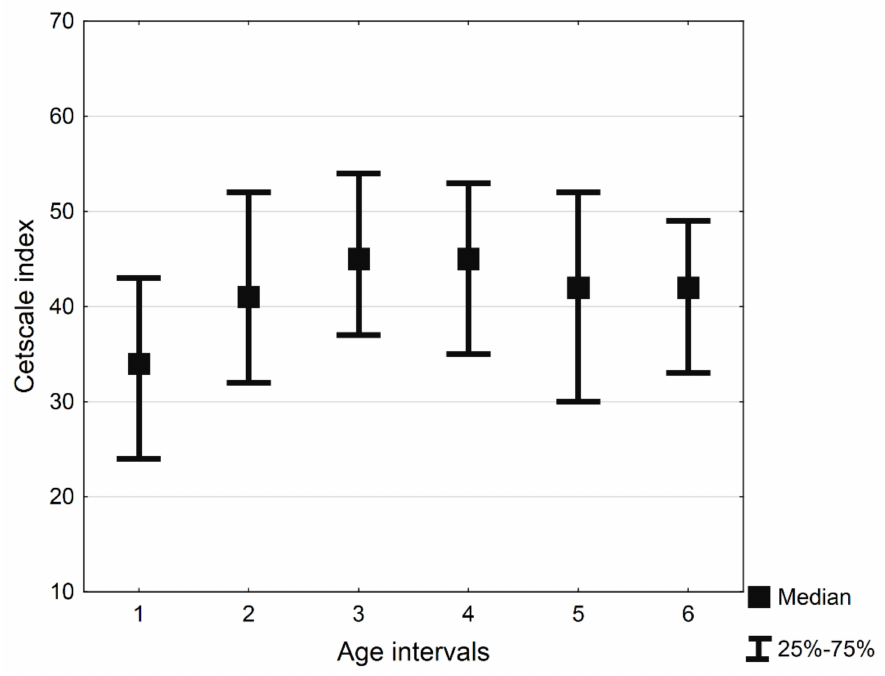
Figure 1. Consumer ethnocentrism in the food market in various age groups. Note: Age intervals: 1. 15–24, 2. 25–34, 3. 35–44, 4. 45–54, 5. 55–64, and 6.